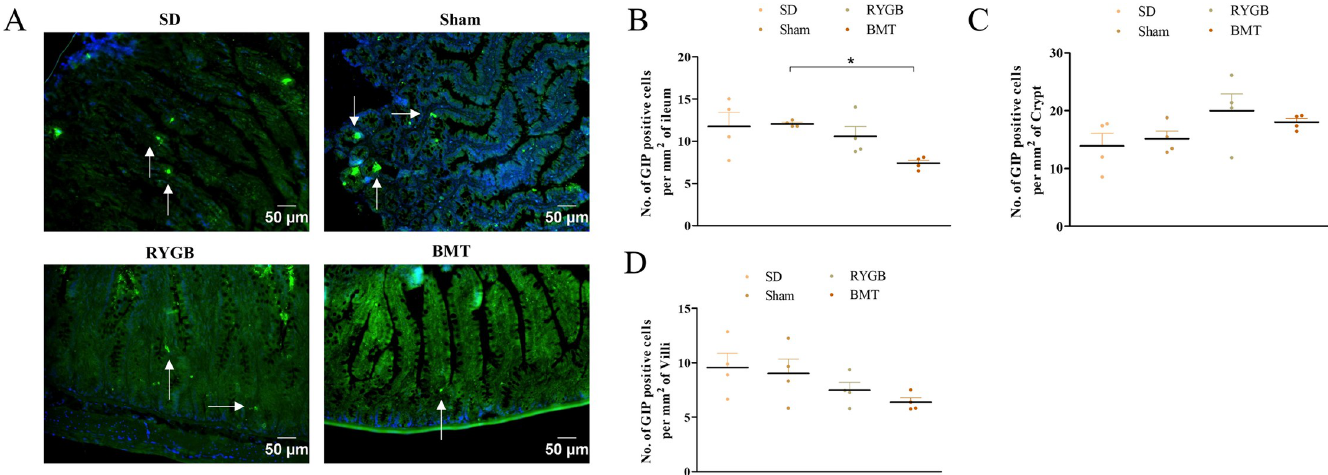
Fig 3. Effects of RYGB, BMT and sham surgery on GIP positive cell distribution in the ileum of ZDSD rats. (A) Representative images showing GIP (green); arrows indicate GIP positive cells. Nuclei are demonstrated using DAPI staining (blue). (B) number of GIP positive cells per mm 2 of ileum, (C) number of GIP positive cells per mm 2 of crypt and (D) number of GIP positive cells per mm 2 of villi analyzed in ileum sections. Normal SD rats are included for comparison. Values are mean ± SEM (n = 4) with statistical significance evaluated using one-way ANOVA. � p < 0.05 compared to sham rats. Analyses carried out on ~200 cells per group.